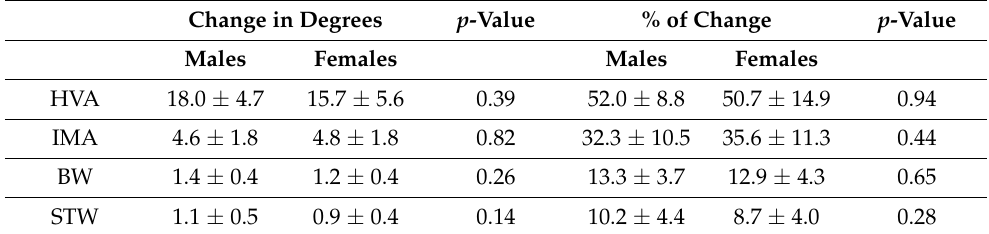
Table 3. Changes in preoperative and postoperative hallux valgus angles by sex. Change in Degrees